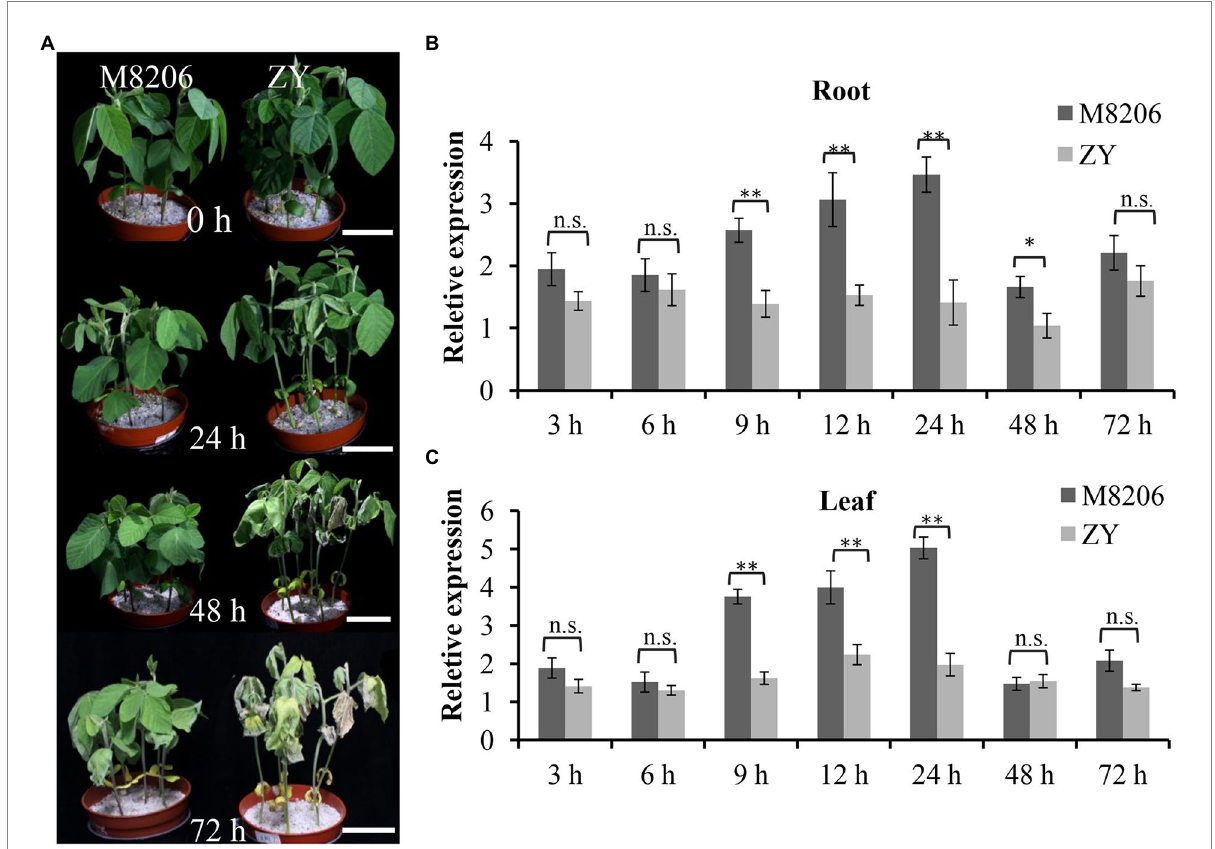
FIGURE 2 Phenotype and relative expression of GmNHX6 in two soybean varieties in response to alkali stress. (A) Phenotypes of two soybean varieties at 0, 24, 48, and 72 h after 90 mM NaHCO 3 treatment. The 12-day-old seedlings were subjected to treatment. Bar = 5 cm. (B,C) Relative expression of GmNHX6 in response to alkali stress in roots and leaves, respectively. Soybean seedlings were treated with 0 or 90 mM NaHCO 3 for 3, 6, 9, 12, 24, 48, and 72 h. Roots and leaves receiving 0 mM NaHCO 3 treatment at each time point were used as controls. Data represents the mean ± standard deviation of three biological replications with three repeats within each replication (n = 3 × 3 = 9). Differences between two soybean varieties were evaluated using the two-tailed Student’s t- tests (n.s., not significant; * p < 0.05; ** p <